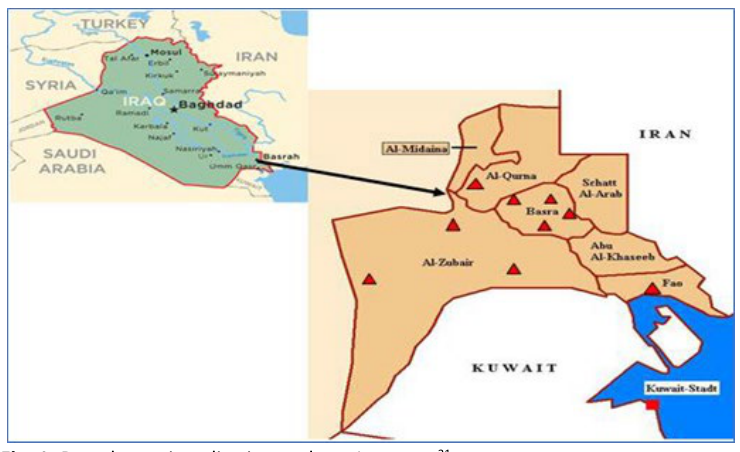
Fig. 1. Basrah province lies in southern Iraq map 31 . Table 2. Animal characteristics factors associated with seropositivity of brucellosis in sheep